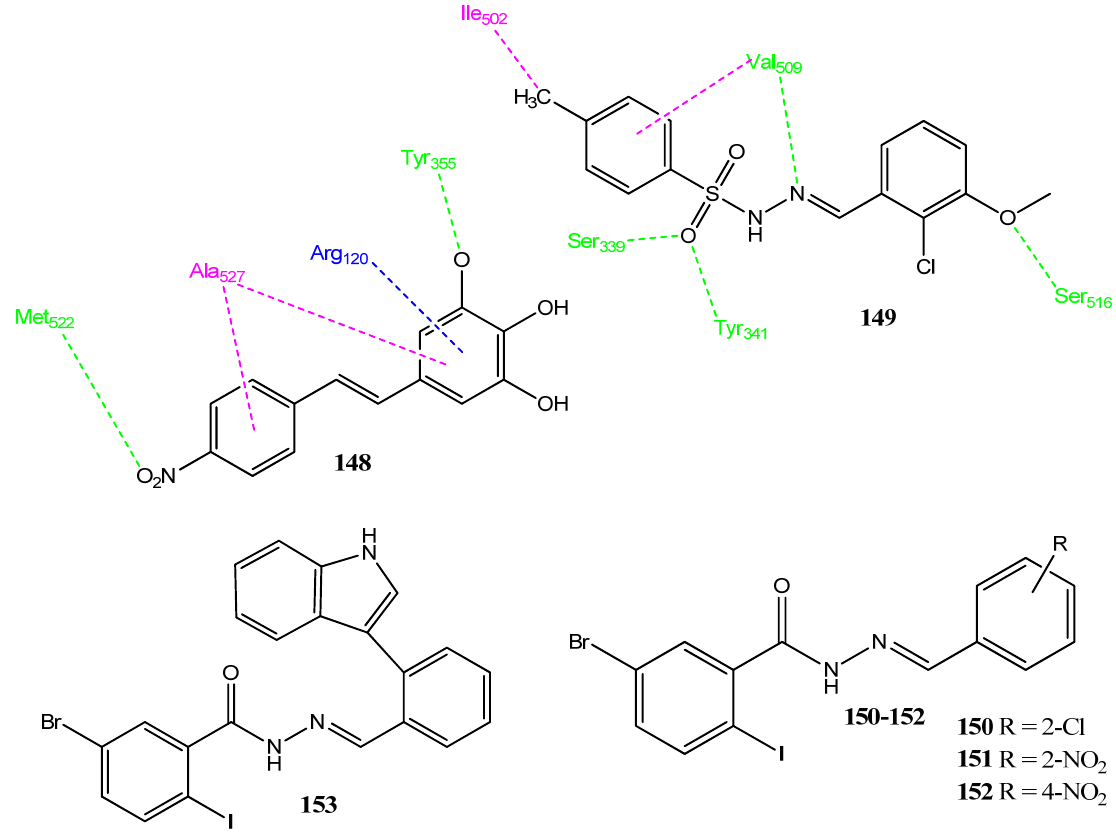
Figure 29. Stilbene and hydrazone